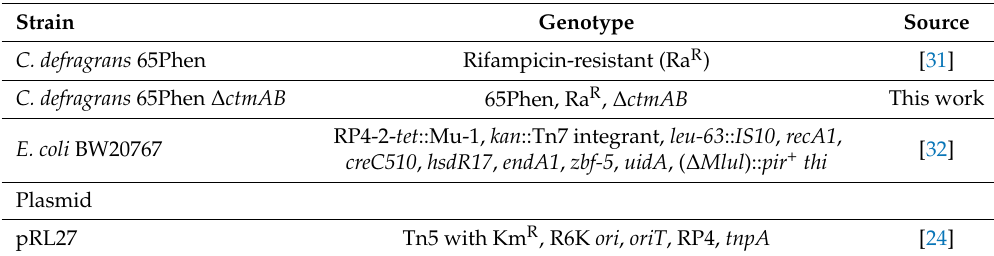
Table 4. List of bacterial strains used in this